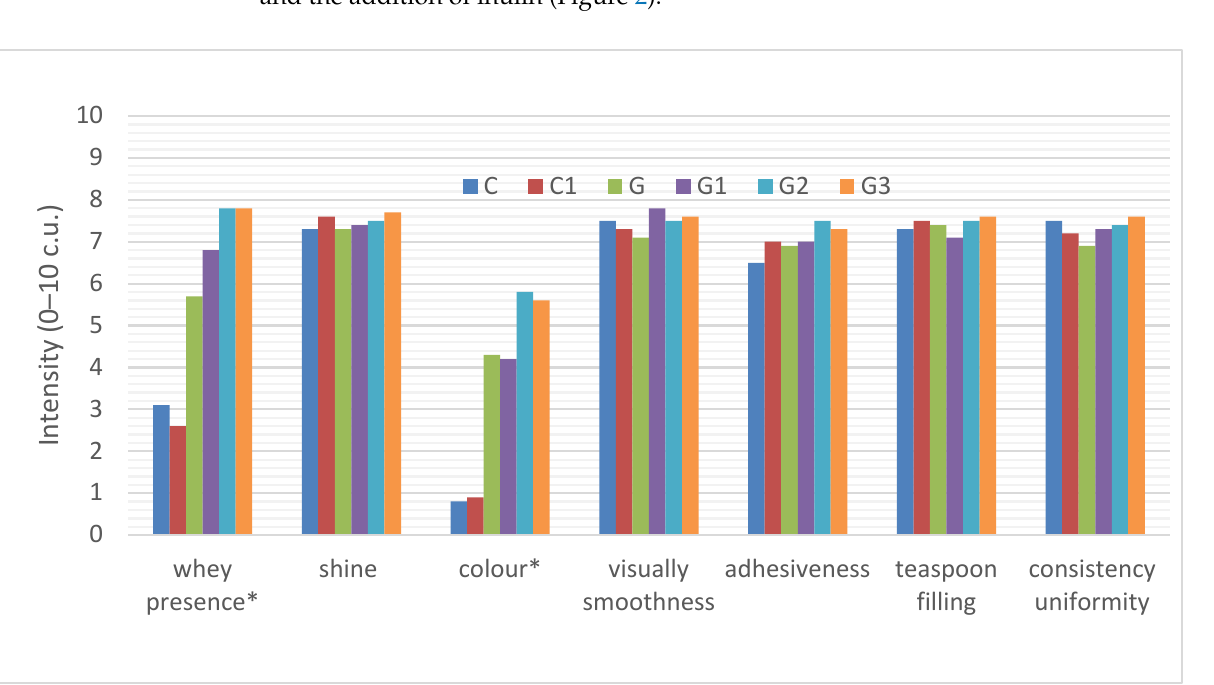
Figure 2. Sensory profile of the appearance of yoghurts C, C1, G, G1, G2. The abbreviations in the figure refer to the control sample (C), control yoghurt with 6% inulin (C1), yoghurt with green tea (G), yoghurt with green tea and 3% inulin (G1), yoghurt with green tea and 6% inulin (G2), yoghurt with green tea and 9% inulin (G3) (* significantly differed at p ≤ 0.05). The control sample (C) was white (0.8 c.u.) with a shiny surface (7.3 c.u.) and